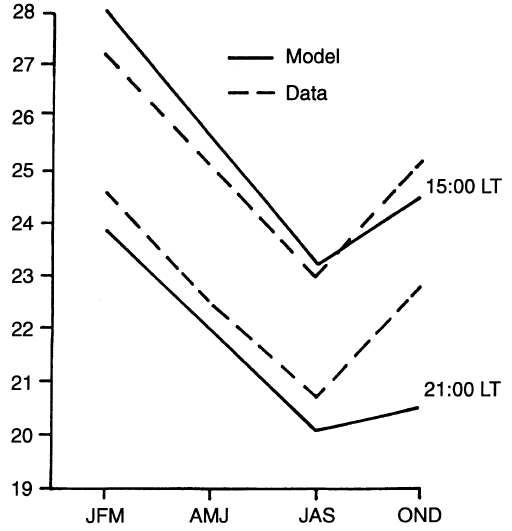
Fig. 13. Simulated and observed three-month averages of the tem- perature at 15:00 LT and 21:00 LT. The model values refer to the simulation at the level of 990 hPa at a gridpoint situated 5 km inland from both the SN and EW coastlines; and the data correspond to air surface values near coast for 1972 (DHN). Units are